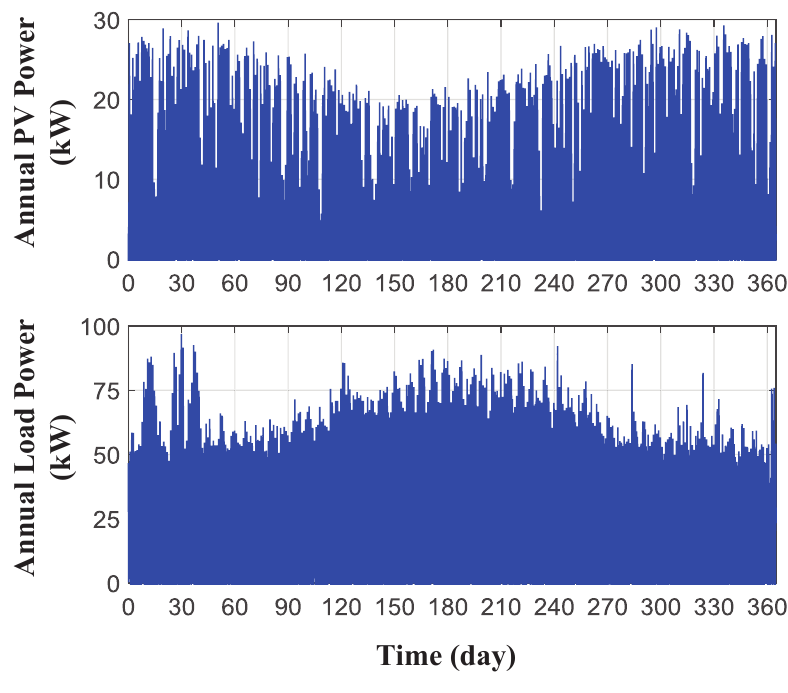
Figure 7. Annual PV and load power data of a residential building.